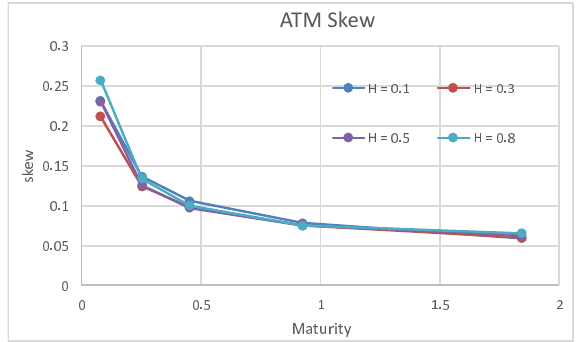
Figure 3. ATM skew with respect to H 1 , the Hurst index of volatility persistence. The model parameters are listed in Table 1.